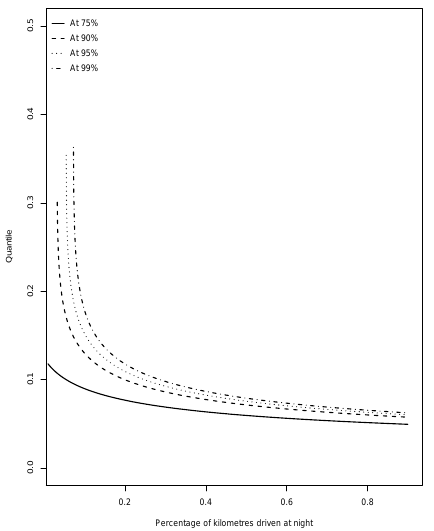
Figure 1. Quantiles of percentage of kilometres driven over the speed limit ( Y 1 ) in the y -axis for Profile 1 given the values of percentage of kilometres driven at night ( Y 2 ) in the x